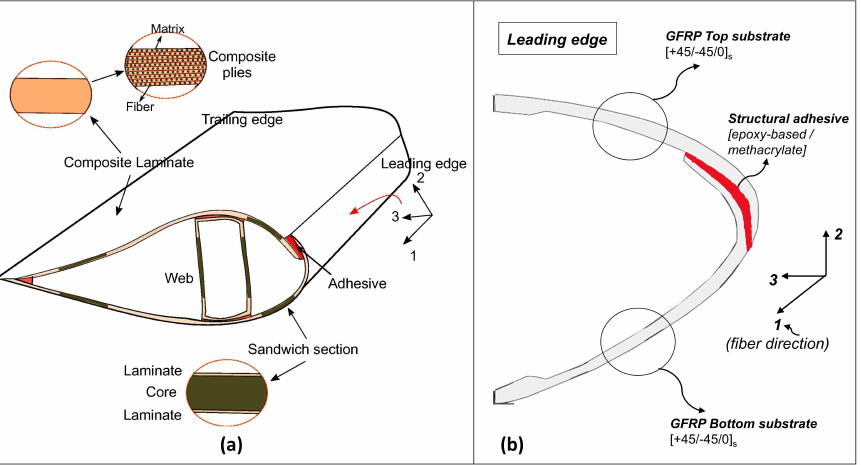
Figure 2. ( a ) Wind turbine blade cross section [9]. ( b ) Leading edge joint with top and bottom substrate with material orientation ( [+45/ − 45/0] s ) (where 0-degree layer is along the blade